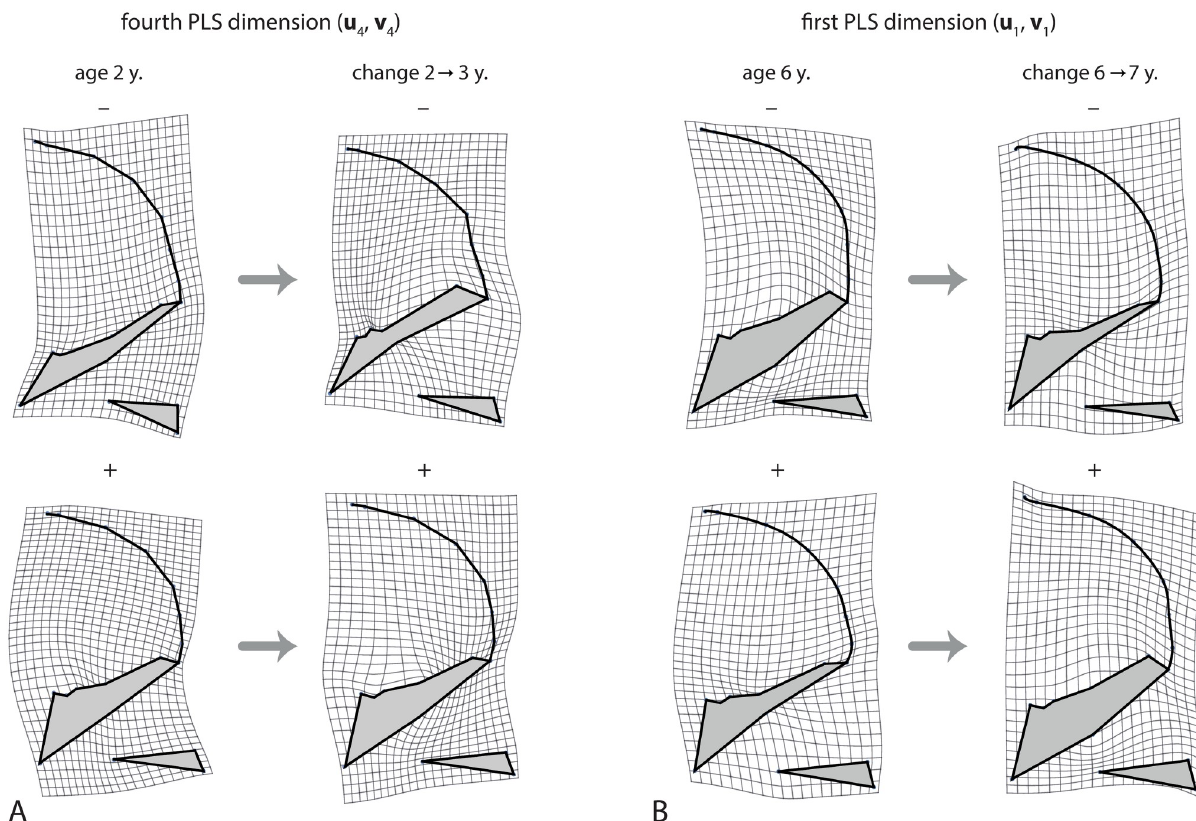
Fig 9. Further features of craniofacial shape. (A) The fourth dimension of the PLS between craniofacial shape at age 2 and the shape change from age 2 to 3 years. This dimension reflects the relative orientation of the face and posterior cranial base, but unlike the previous dimensions these shape features are not canalized; existing individual differences are even amplified. (B) Canalization of craniofacial shape from 6 to 7 years of age (first PLS dimension). Individuals with a relatively thick cranial base at age 6 undergo reduced thickening of the cranial base, whereas individuals with a thin cranial based show increased growth in this area. Again, this indicates canalization of the relative dimensions of the upper airways.